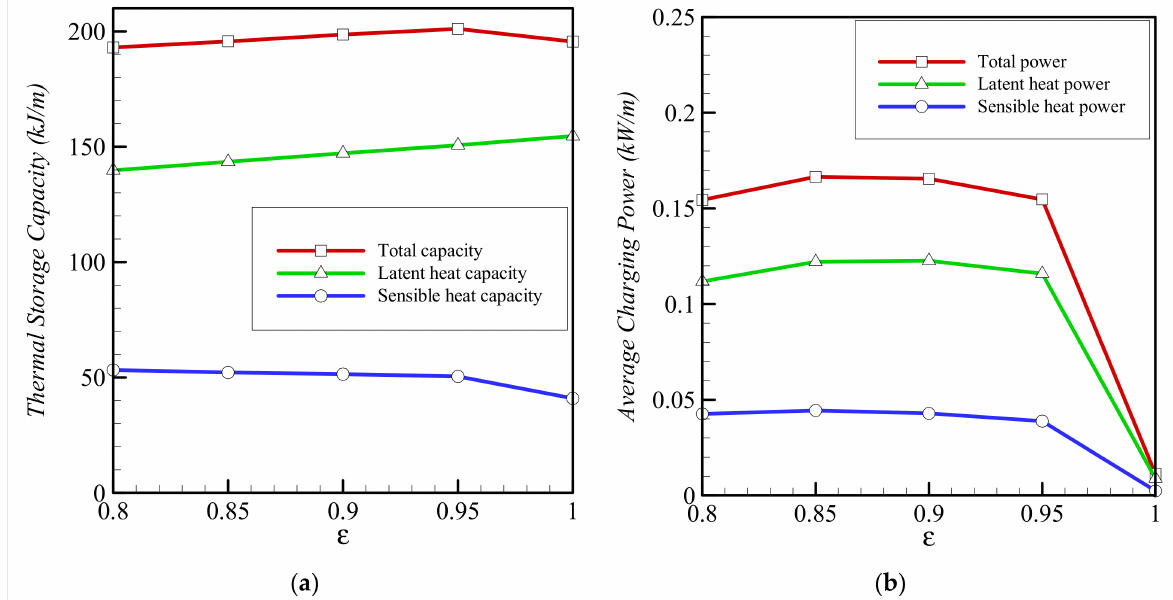
Figure 15. Variations of average thermal storage capacity ( a ) and average charging power ( b ) as functions of porosity ε for copper nanoparticles for eccentricity e = 0.12 r s and nanoparticle volume fraction σ = 0.04.